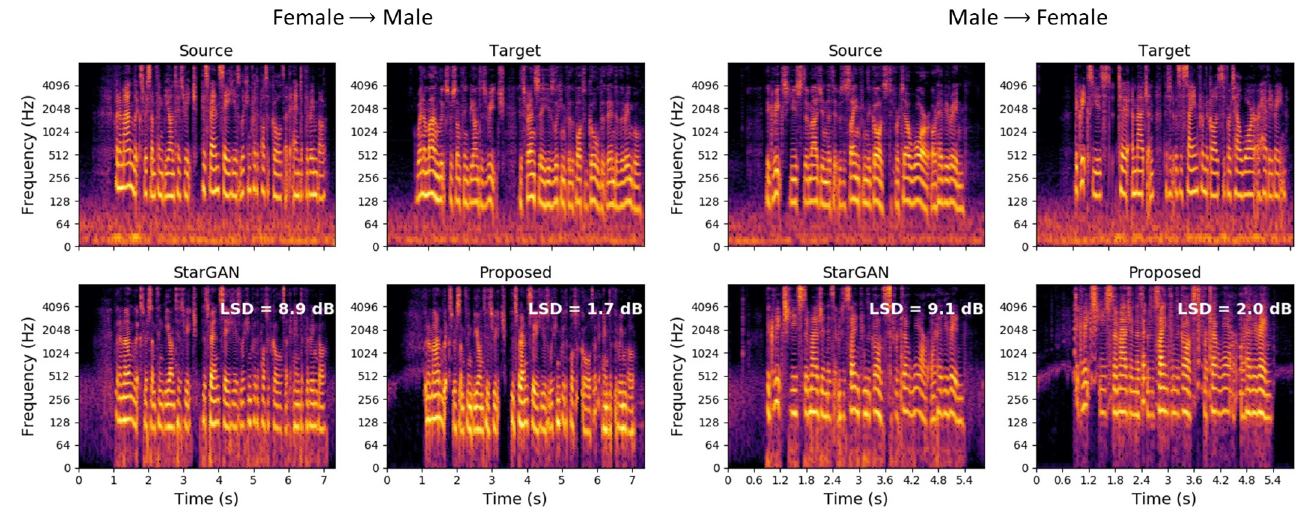
Figure 5. Example of the spectrogram for source, target, and converted speech. The LSD values are averages for the whole set of tested examples.